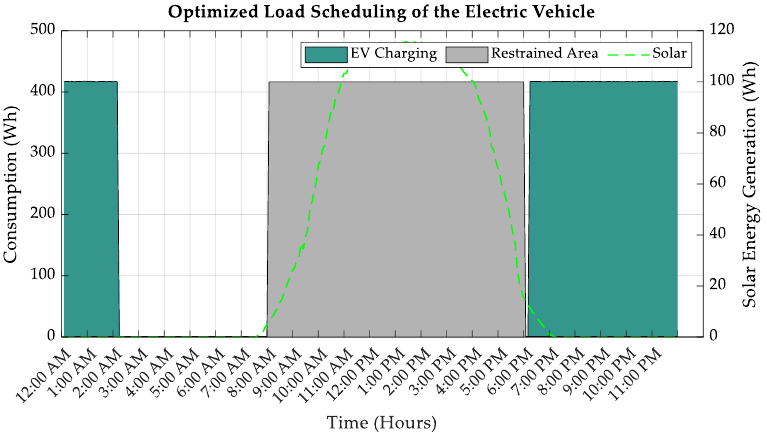
Figure 8. Load scheduling of the Charging of the EV under optimization for Solar Energy.